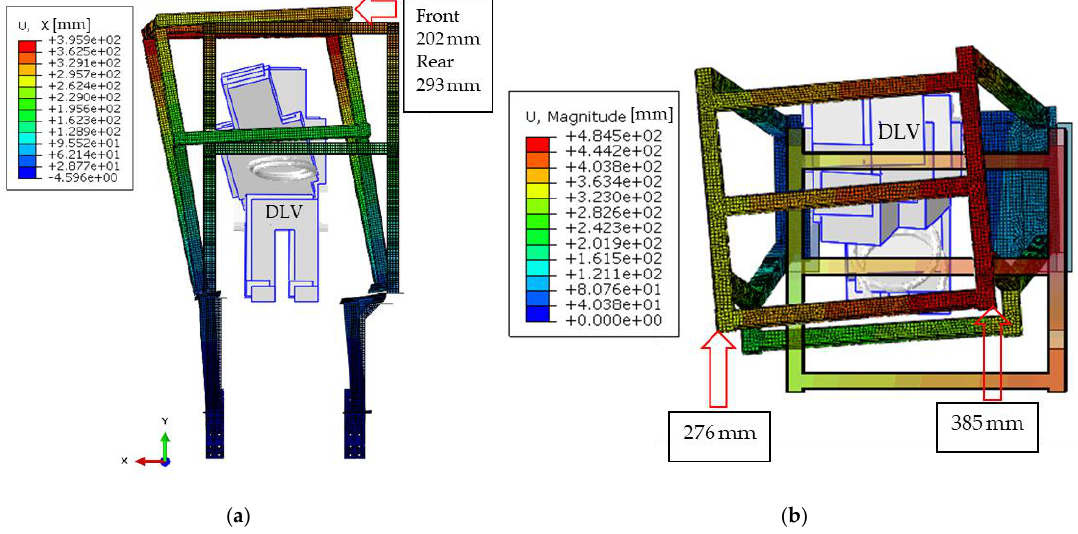
Figure 14. Permanent deflection (expressed in mm) of the ROPS structure after the side and longitudinal loadings: ( a ) front view; ( b ) top view.